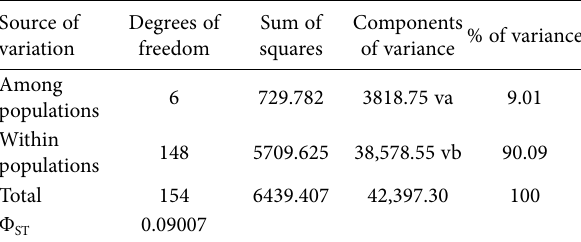
Table 3. Results of the AMOVA for the Tropidurus hispidus popula- tions in the study area. (p < 0.01).